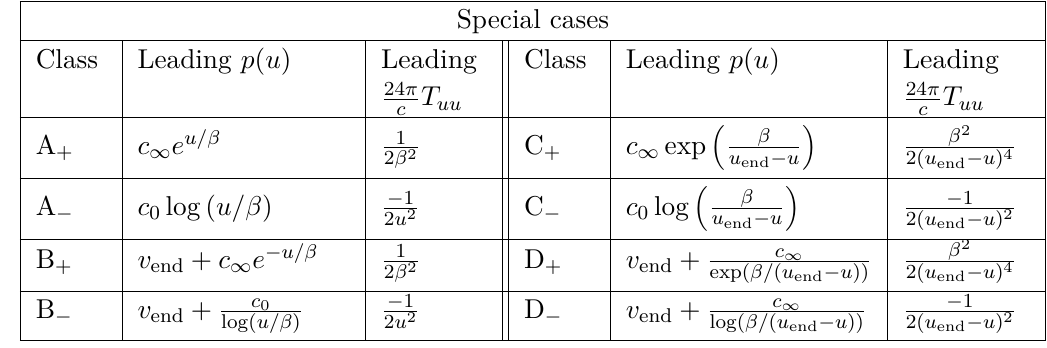
Table 4 . Special cases corresponding to n → ∞ and n → 0 for each type.